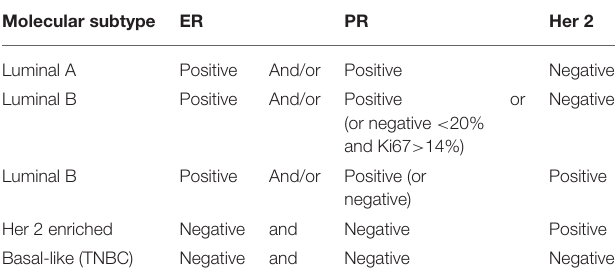
TABLE 1 | Molecular